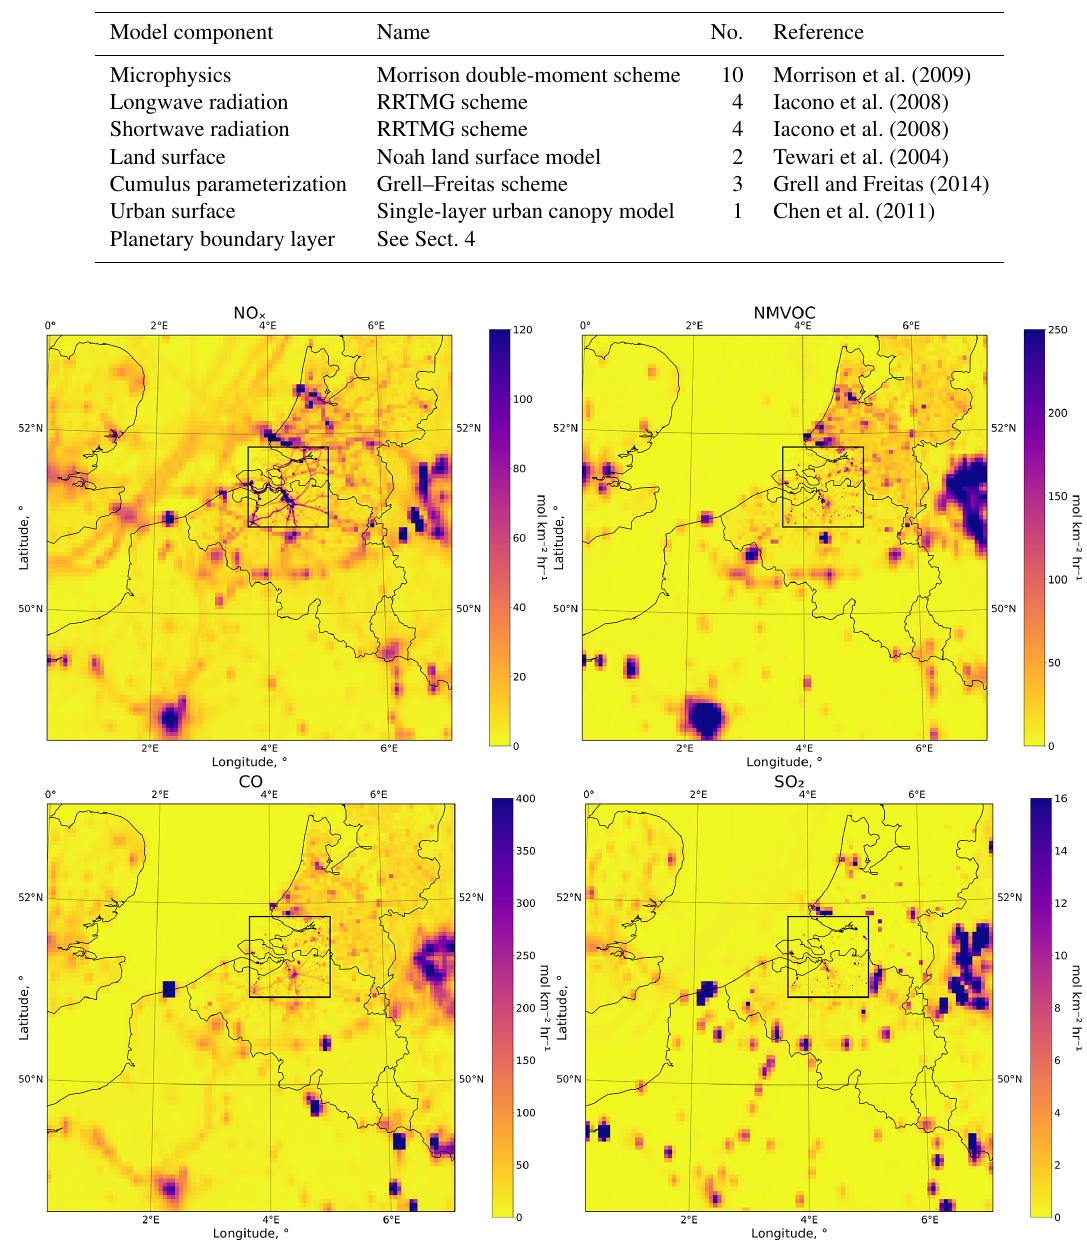
Figure 2. Emissions over the two model domains in their respective resolution (average for the period 15–30 June). The black square is the boundary of the inner domain